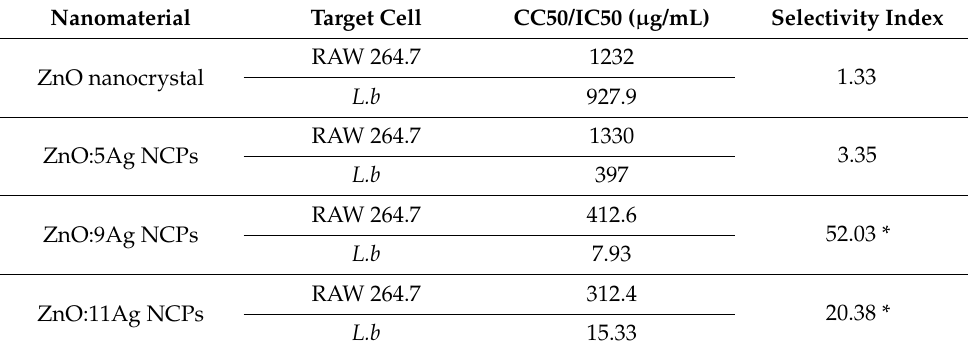
Table 1. Selectivity index of treatments on RAW 264.7 and L.b